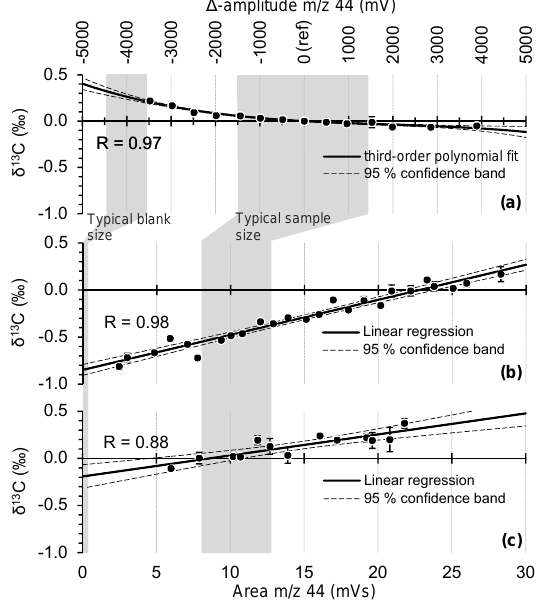
Figure 5. Fractionation effects for δ 13 C: (a) IRMS nonlinearity; δ 13 C dependence on peak amplitude (top x axis), (cid:49) − amplitude is the deviation in intensity ( m/z 44) from the reference peak (ref, δ 13 C and (cid:49) − amplitude = 0). The data are obtained from a total of 177 measurements and mean values with the 1 σ standard deviation are shown. (b) PreCon–GC linearity (bottom x axis); CO 2 sample size dependence for pure CO 2 working standard directly injected to section B. The data are obtained from a total of 318 measurements corrected for IRMS nonlinearity and blank; mean values with the 1 σ standard deviation are shown. (c) Air amount dependence (bot- tom x axis); air sample size dependence for air standards/samples injected to section A. The data are obtained from a total of 46 mea- surements corrected for IRMS nonlinearity, PreCon–GC linearity and system blank. Mean values with the 1 σ standard deviation are shown. The grey bars indicate the typical procedural blank and sam- ple size range of air extracted from ice samples,